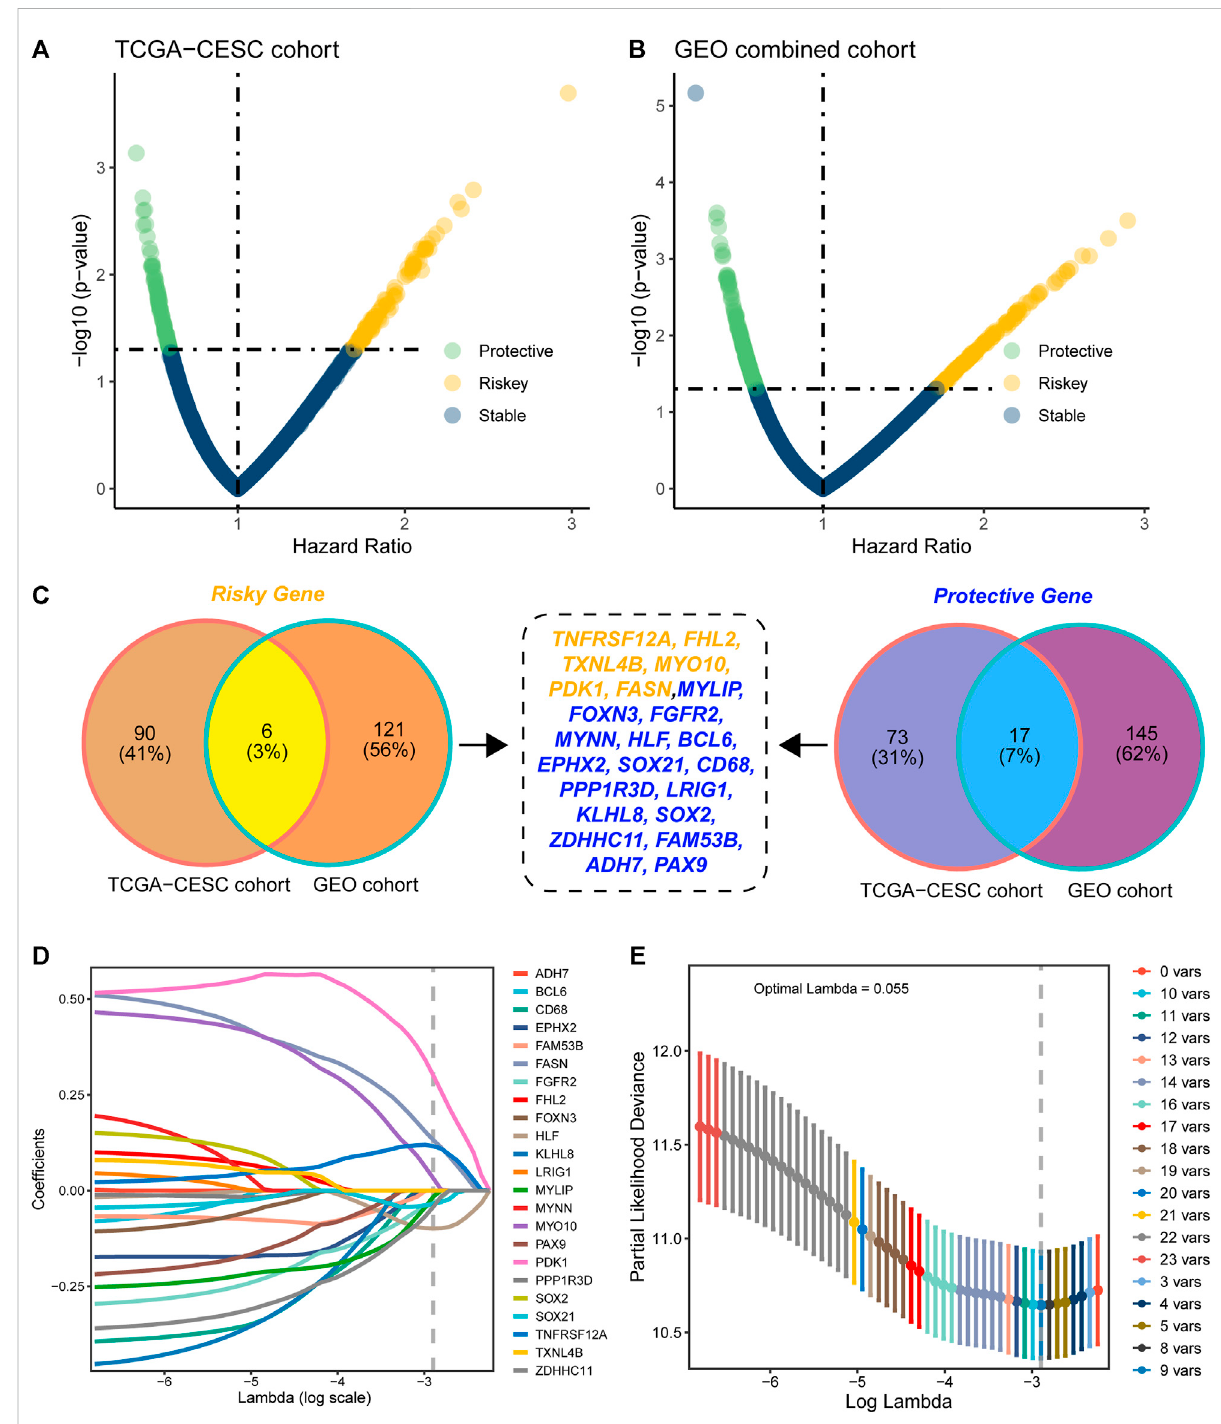
FIGURE 2 Constructionofthehistonemodi fi cation-associated genesignature. (A) Selection oftheprognosticgenesinTCGA-CESCcohort; (B) selection of the prognostic genes in the GEO-combined cohort; (C) Venn plot showing the risk genes and protective genes in both TCGA-CESC and GEO- combined cohorts; (D) optimal tuning parameter (lambda) in the LASSO analysis selected with 10-fold cross-validation and one standard error rule; and (E) LASSO coef fi cient pro fi les of the 23 candidate